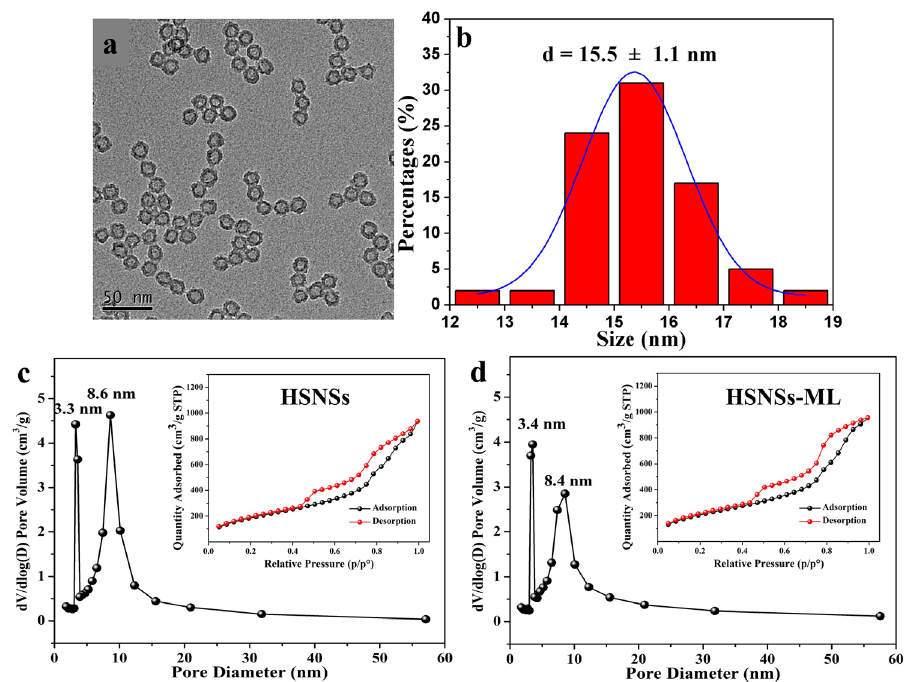
Figure 2. ( a ) Representative TEM images of the as-prepared HSNSs-ML; ( b ) the diameter distribution histogram of HSNSs-ML by calculating 80 individual nanospheres; ( c , d ) the size distribution of the cavity of HSNSs and HSNSs-ML, respectively. Insets in ( c , d ) show their relevant N 2 adsorption-desorption isotherms.